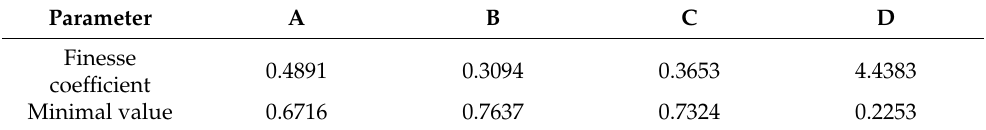
Figure 2. Normalized transmittance characteristics. ( A ) Silver mirror, ( B ) boron-doped diamond film, ( C ) nitrogen-doped diamond film and ( D ) nanocrystalline diamond sheet with silver mirror. Orange lines are meant to guide an eye. The parameters of the obtained plots are presented in Table 1. Table 1. Parameters of the investigated cases: A—silver mirror; B—boron-doped diamond; C— nitrogen-doped diamond; D—nanocrystalline diamond sheet with silver mirror. Table 1. P arameters of the investigated cases: A—silver mirror; B—boron-doped diamond; C—ni- trogen-doped diamond; D—nanocrystalline diamond sheet with silver mirror. Parameter A B C D Parameter A Finesse